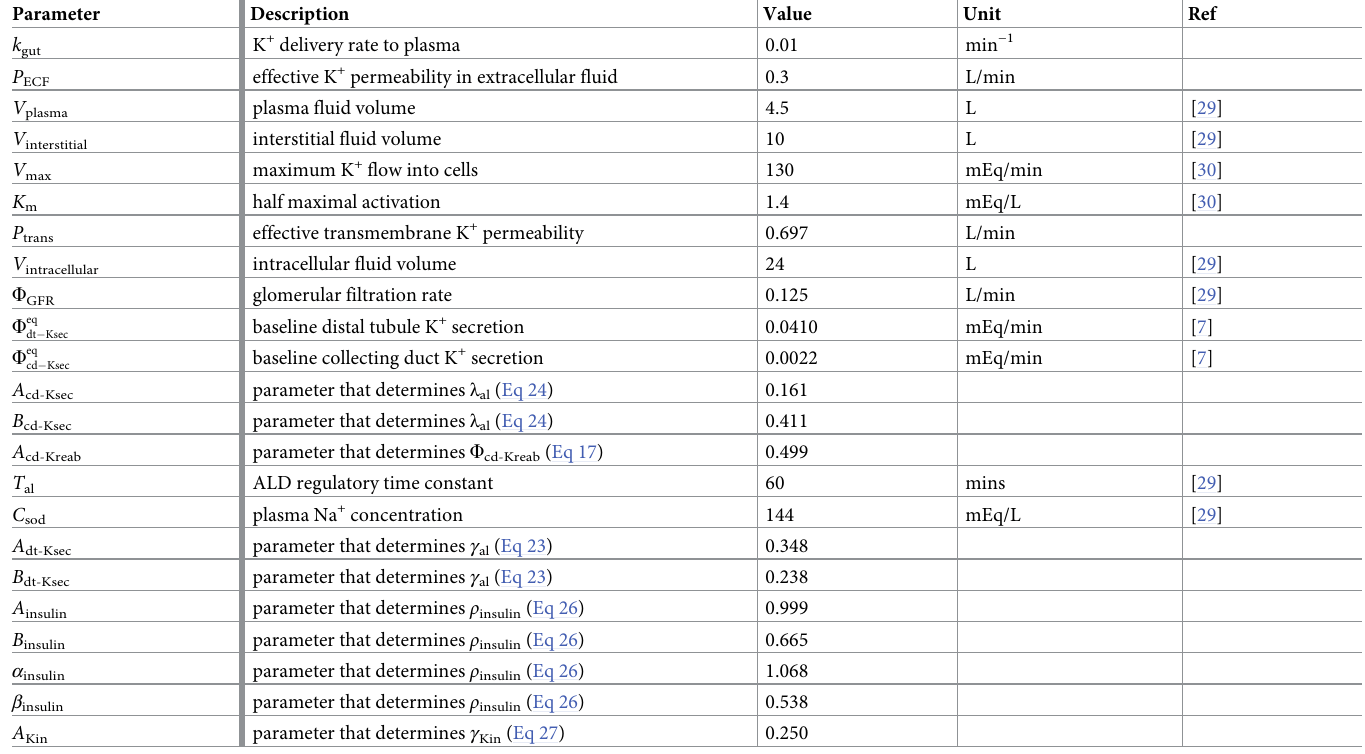
Table 1. Model parameter values used in the baseline K + homeostasis mathematical